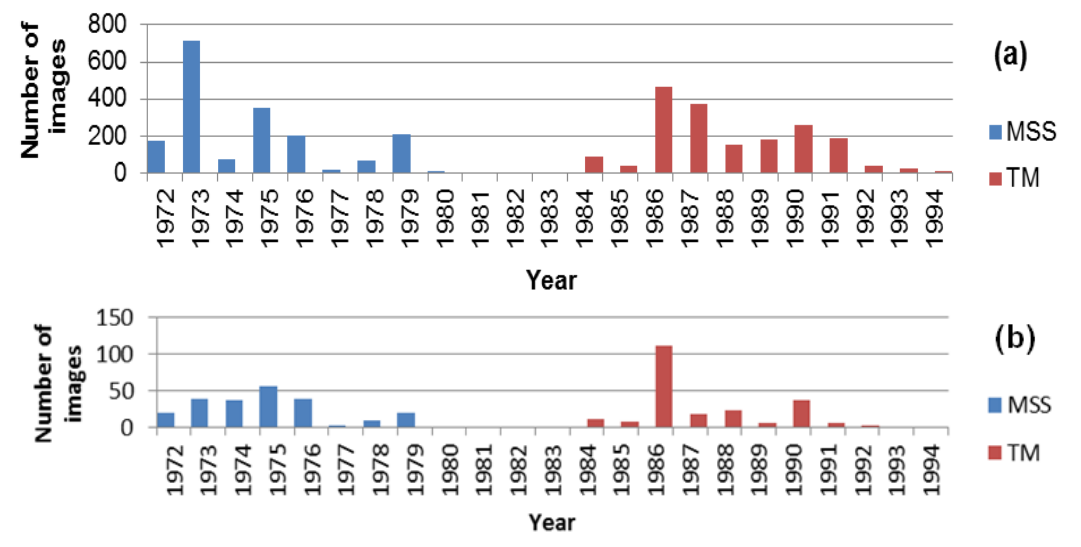
Figure 4. Comparison of the acquisition years of the best candidates selected for Landsat Multispectral Scanner (MSS) (around 1975) and Thematic Mapper (TM) images (around 1990) for ( a ) the whole sub-Saharan Africa ( n = 1,799), and only for ( b ) West Africa ( n =